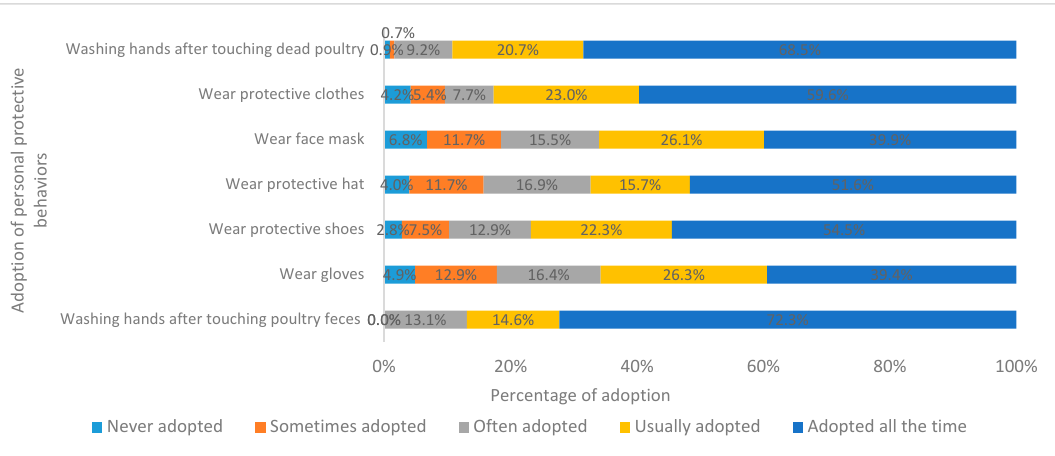
Figure 4. Percentage of respondents reporting adoption of personal protective behaviors against AI.